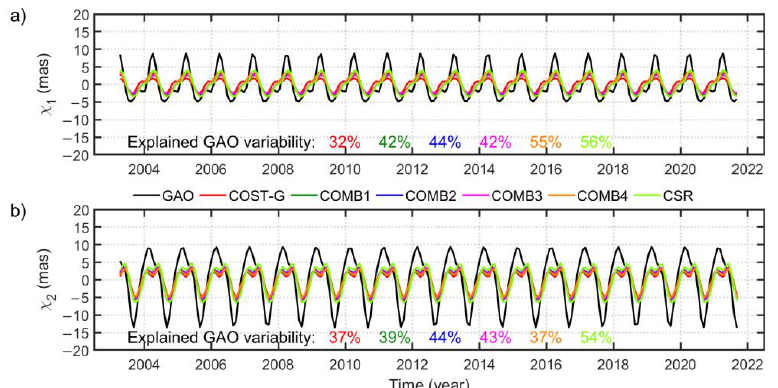
Figure 6. Time series of seasonal χ 1 ( a ) and χ 2 ( b ) components of GAO and gravimetric excitation determined from a single GRACE/GRACE-FO solution (CSR), combined GRACE/GRACE-FO solution (COST-G), and the four combined solutions developed in this study (COMB1, COMB2, COMB3, and COMB4). The plots include values of explained GAO variability, which was computed as a relation between STD of gravimetric excitation and STD of GAO (STD gravimetric excitation /STD GAO ) given in %. Similar to the overall variability, we check the correspondence between GAO and